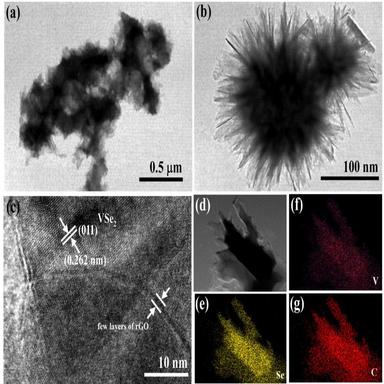
(a, b) TEM images of rGO-VSe2 nanohybrid; (c) HRTEM images of rGO-VSe2 nanohybrid; and (d–g) EDS mapping images of rGO-VSe2 nanohybrid.